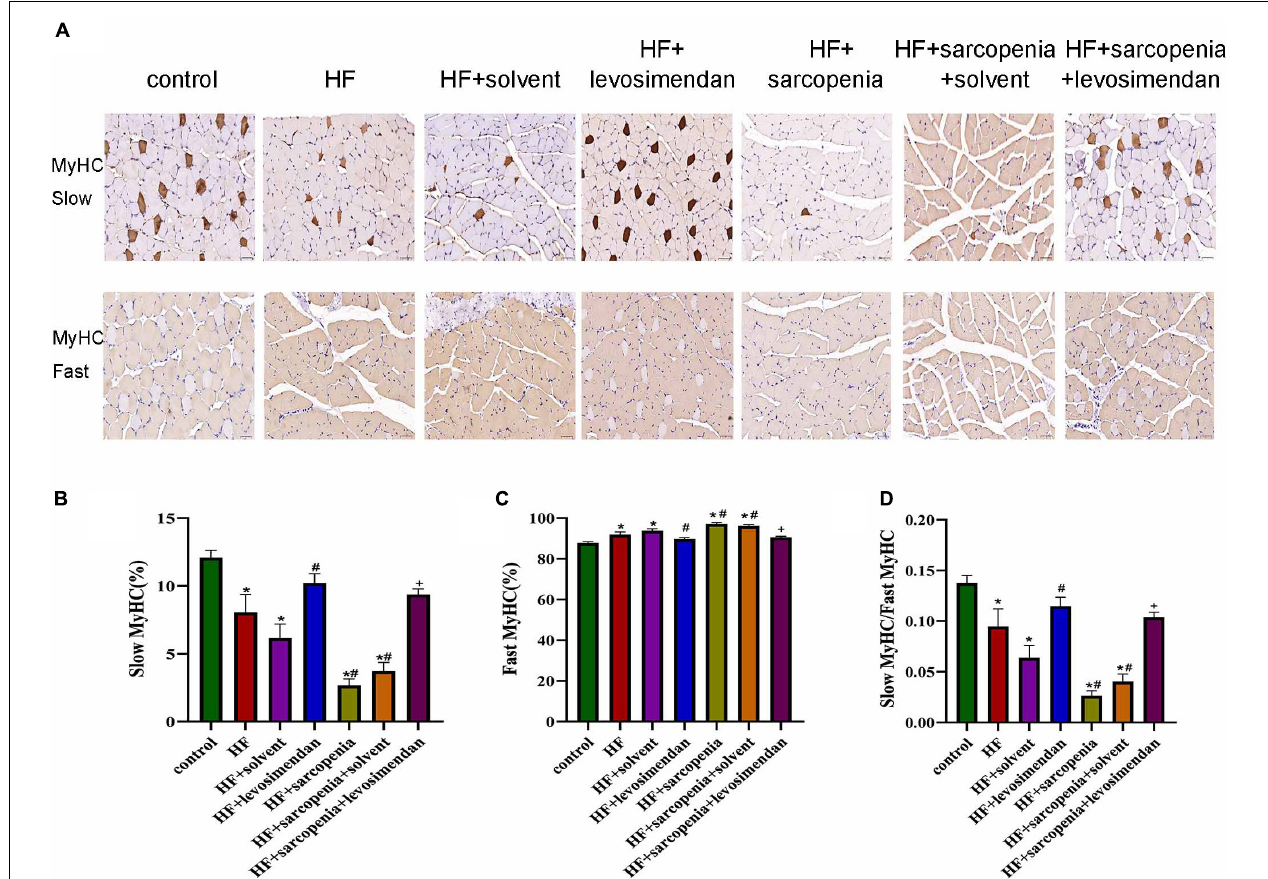
FIGURE 4 | Levosimendan promoted slow muscle fiber differentiation in mice with heart failure and sarcopenia (A) immunohistochemical staining of fast and slow myosin heavy chain. (B) Ratio of slow muscle fibers (%). (C) Ratio of fast muscle fibers (%). (D) Ratio of slow to fast muscle fibers. N = 5–12. * P < 0.05 vs. control, # P < 0.05 vs. HF, + P < 0.05 vs. HF + sarcopenia. Bar = 40 µ